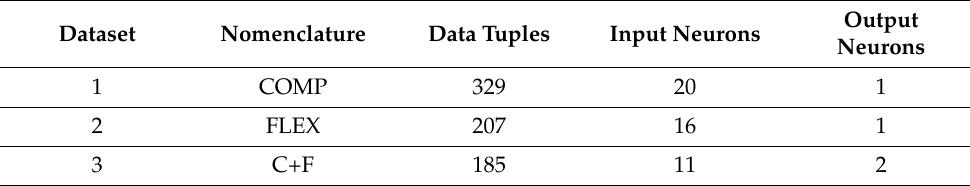
Table 4. Outline of each dataset.